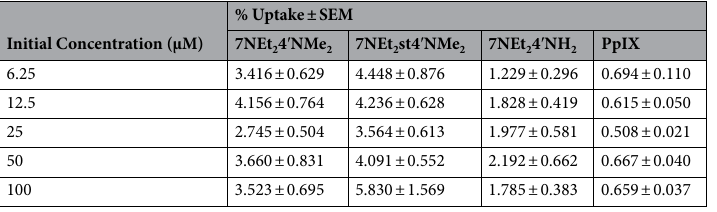
Table 3. Percentage of compounds absorbed/adsorbed by HaCaT cells after 4 h of incubation for the different concentrations of compounds. The results are presented in % ± SEM (n =